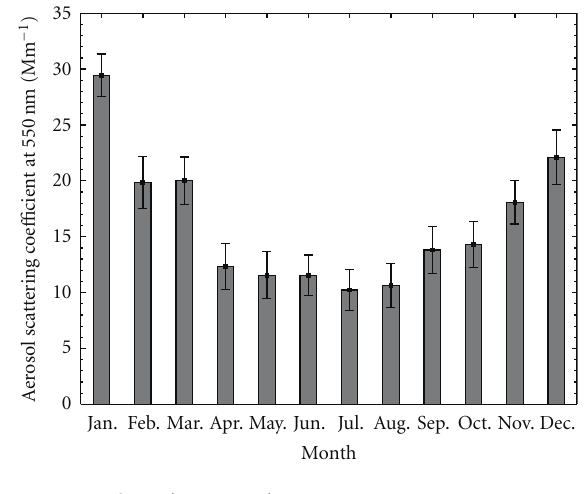
Figure 1: Seasonal variation of the σ scat (geometric mean) averaged over a period of 10 years from June, 2001 to December, 2010. The error bars represent the geometric standard deviation of the data.